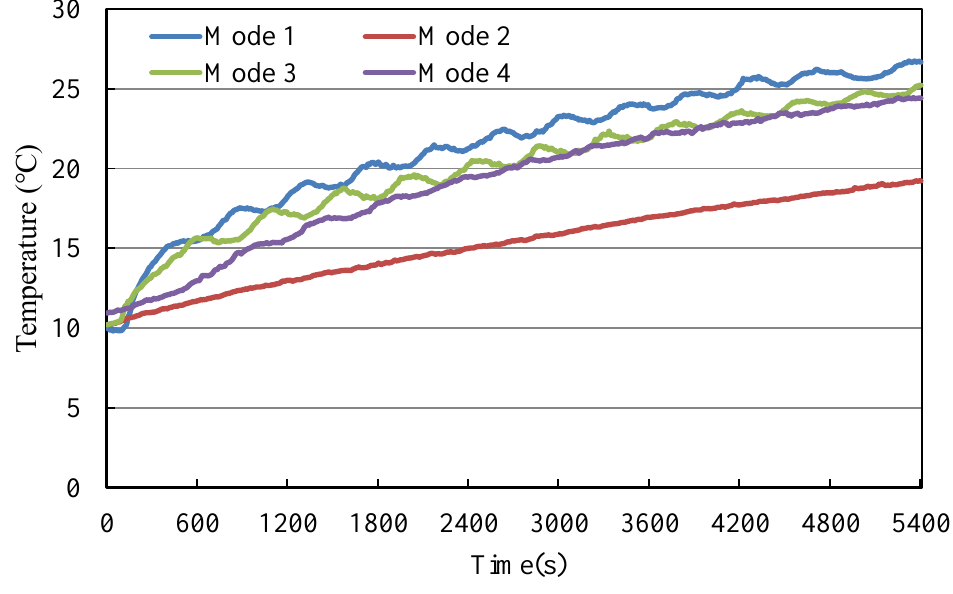
Figure 10. Air temperature (120 cm from floor surface). Table 4. Indoor temperature pattern after heating for 90